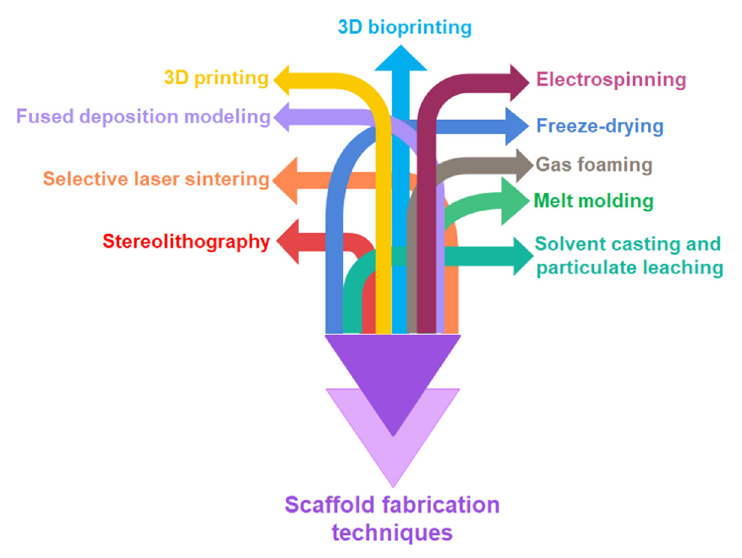
Figure 7. Conventional and advanced scaffold fabrication techniques.